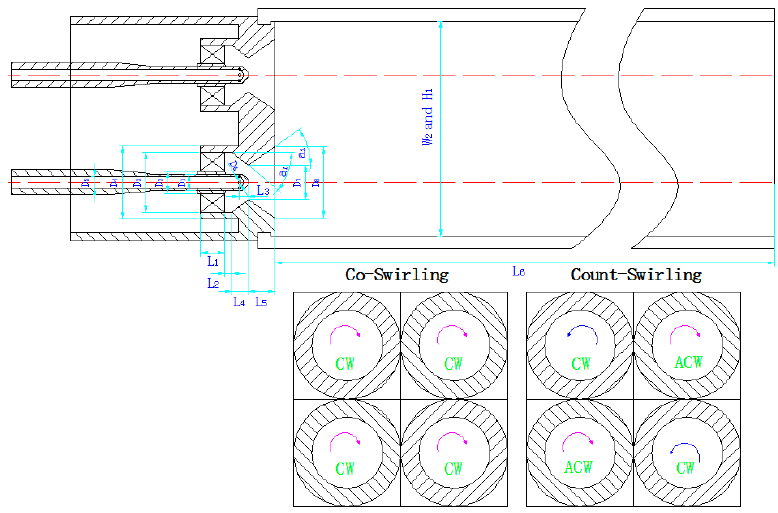
Figure 2. Schematic diagram of the co-swirling and count-swirling swirler arrays of four-point LDI combustors.